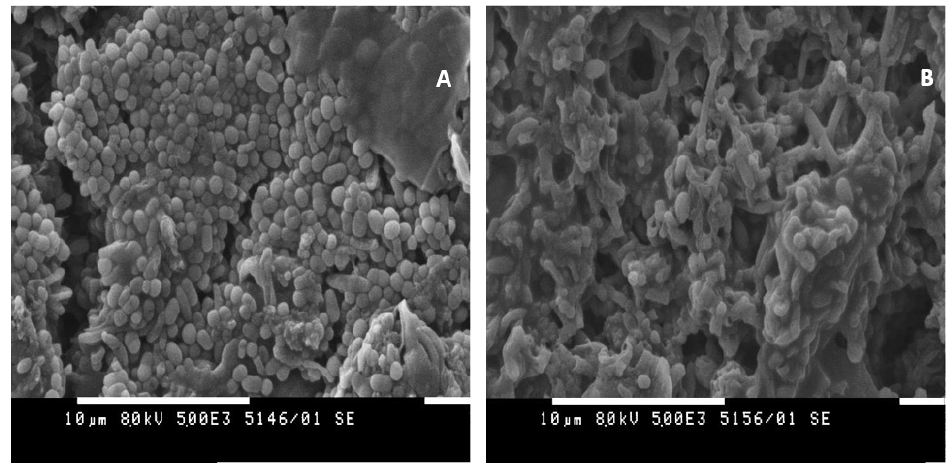
Figure 3. SEM image of free cell samples for SEM analysis: ( A ) control experiment; ( B ) with the constant electric field (0.8 V).